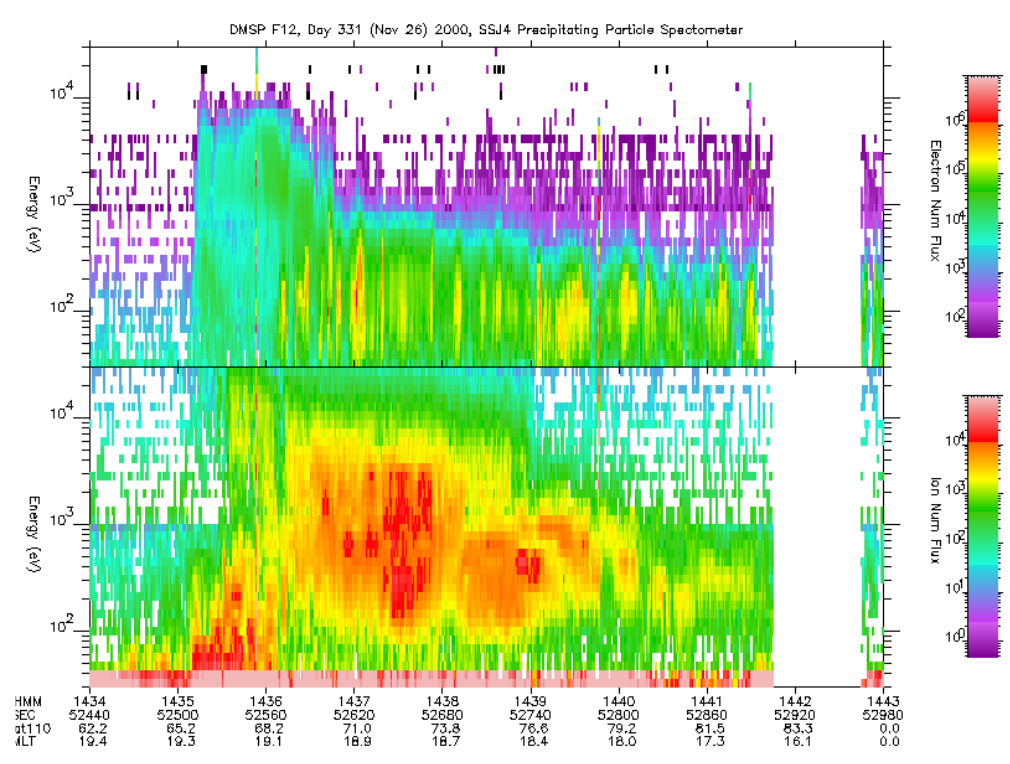
Fig. 3. DMSP F12 energy spectrogram of electrons (top) and ions (bottom).